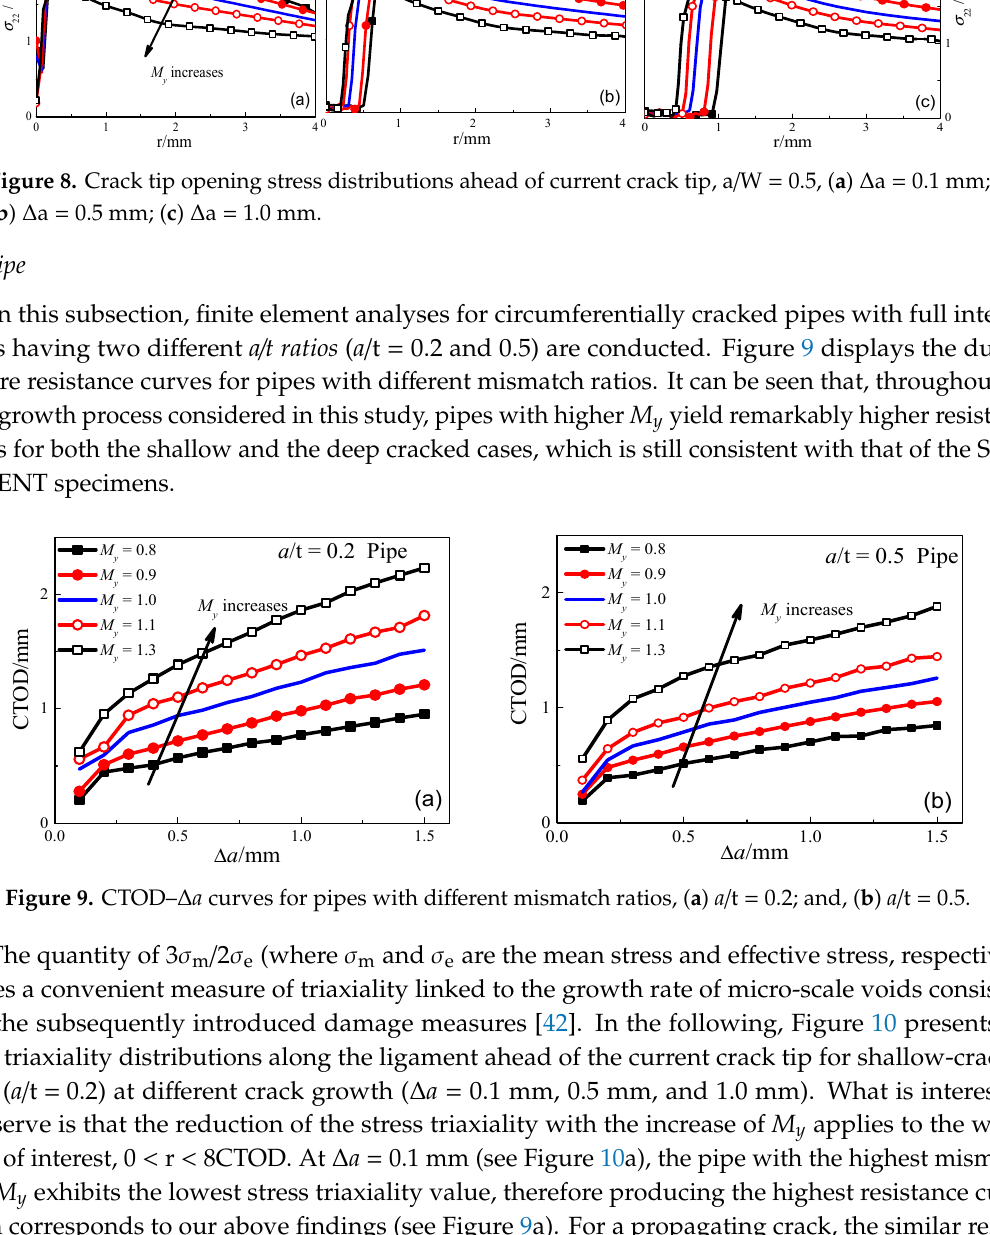
Figure 10. Stress triaxiality distributions ahead of the current crack tip for pipes at different crack propagation, a /t = 0.2, ( a ) Δ a = 0.1 mm; ( b ) Δ a = 0.5 mm; and, ( c ) Δ a = 1.0 mm. 3.4. Comparisons of Different Models It has been shown that, in the elastic-plastic regime, the use of standard deeply notched SENB with crack depth of a/W = 0.5 specimens provide a conservative assessment of fracture toughness for both weld metal and because of the high constraint that is associated with this specimen geometry. Use of specimen geometries and loading modes associated with lower constraint (e.g., SENT specimens), allow for improved estimates of fracture toughness to be made that are appropriate for the assessment of circumferential flaws in pipe girth welds. The resistance curves of all the models mentioned above are plotted together in Figure 11. Three different mismatched cases from under- match to even-match and over-match are considered herein for comparison. A minor influence of geometric models on the crack initiation toughness can be found for all these three mismatched cases. With the increase of M y (e.g., M y = 1.0 and 1.3), the difference in resistance curves for pipes ( a /t = 0.2,